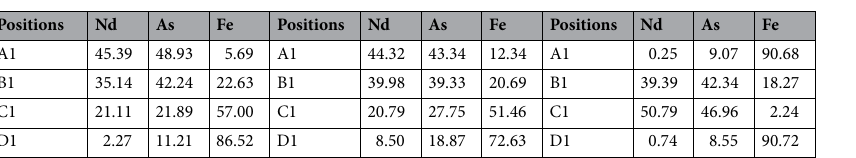
Table 3. EDS analysis results of different atomic ratio samples